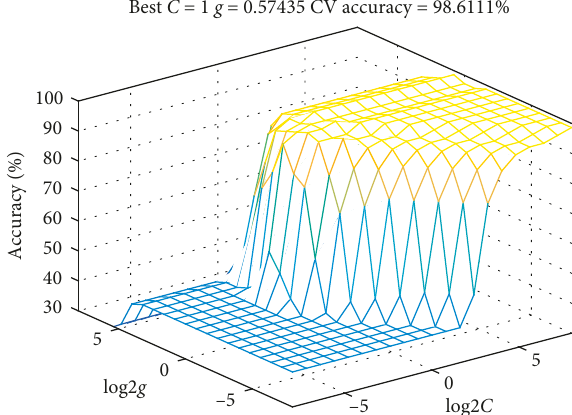
Figure 4: The GS optimization process of SVM models.